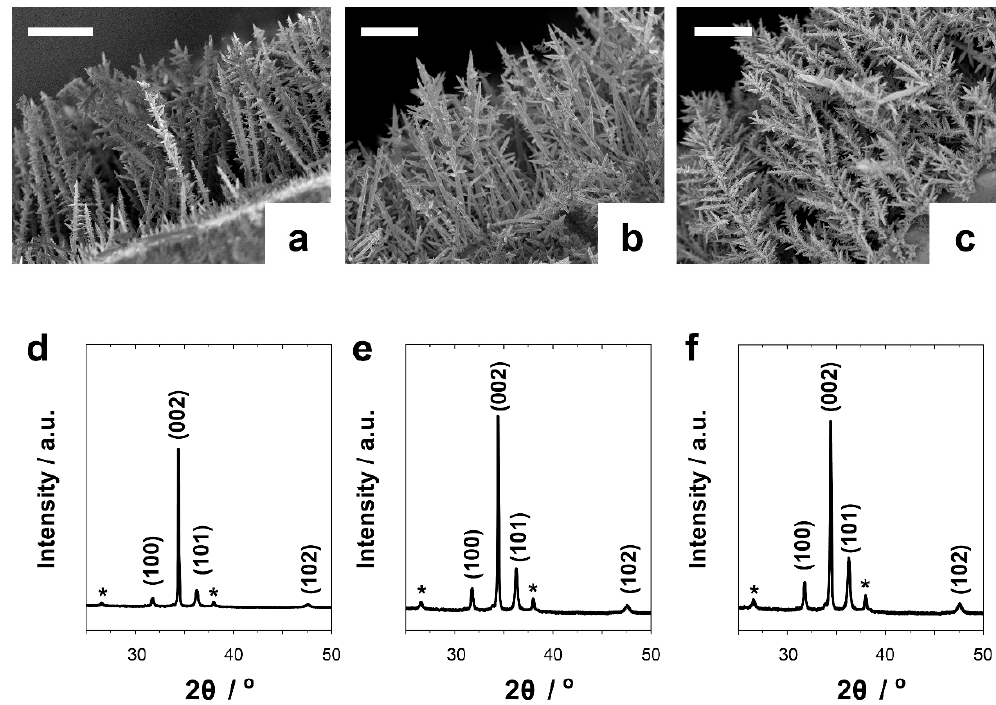
Figure 1. ( a – c ) FE-SEM micrographs and ( d – f ) XRD patterns of ZnO microstructures electrodeposited on a fluorine-doped tin oxide film on a glass substrate under different oxygen flux bubbling conditions: ( a , d ) 1 L min − 1 , ( b , e ) 3 L min − 1 , and ( c , f ) 12 L min − 1 . Scale bar: 20 µm. Diffraction peaks that correspond to fluorine-doped tin oxide substrate structures are indicated with a *. Table 1. Oxygen flux, magnetic stirring and potential used in the electrodeposition process, and morphology, structure, and BET surface area of electrodeposited micro / nanoferns. Magnetic Potential / V vs. Oxygen Stirring / rpm Ag / AgCl / KCl (3 M) Flux / L min − 1